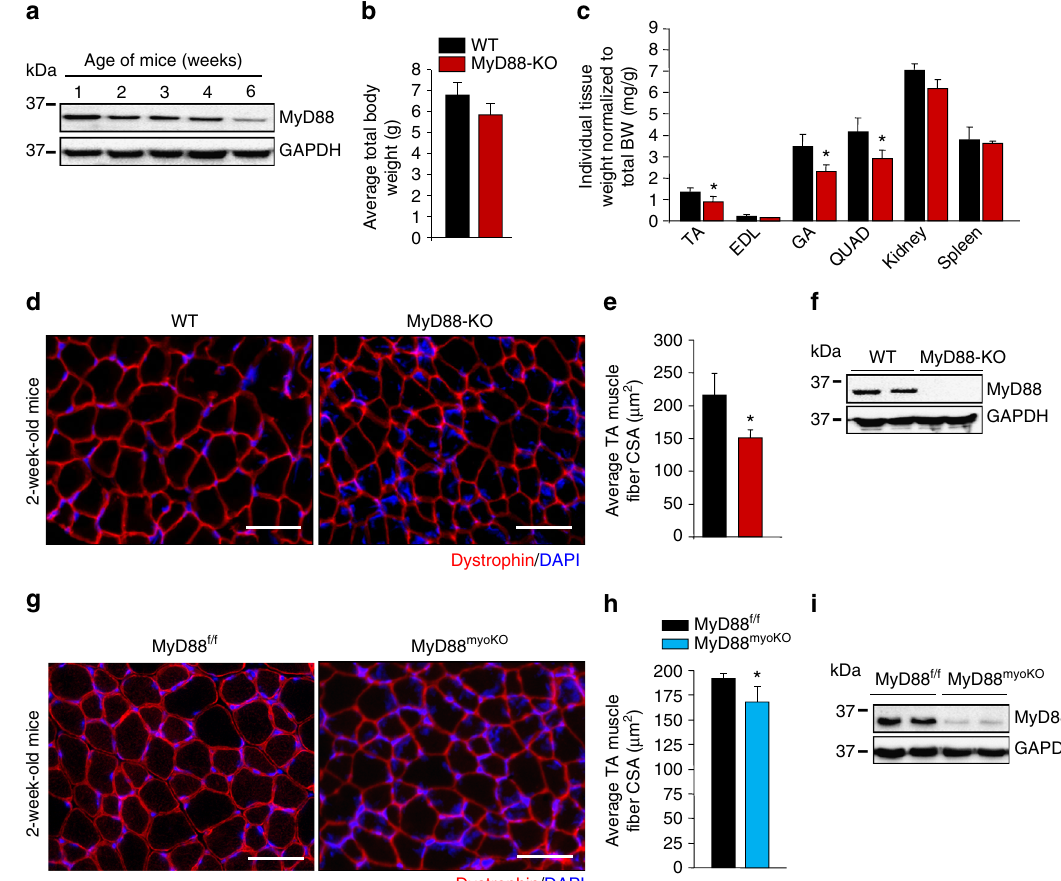
Fig. 1 MyD88 regulates postnatal growth of skeletal muscle. a Gastrocnemius (GA) muscle was collected from WT mice at indicated ages and protein extracts made were immunoblotted for MyD88 and an unrelated protein GAPDH. b Total body weight of 2-week-old WT and MyD88-KO mice. c Tibialis anterior (TA), extensor digitorum longus (EDL), gastrocnemius (GA), and quadriceps (QUAD) muscles, kidney, and spleen were isolated from 2-week-old WT and MyD88-KO mice and their individual wet weight normalized to body weight is presented here. N = 4 mice in each group. * p < 0.05 from WT mice by unpaired t -test. d TA muscle from 2-week-old WT and MyD88-KO animals was processed for histological and morphometric analysis. Representative photomicrographs of dystrophin-stained TA muscle sections from WT and MyD88-KO mice. Scale bar: 50 µ m. e Quanti fi cation of average myo fi ber cross- sectional area (CSA) in TA muscle of 2-week-old WT and MyD88-KO mice. N = 4 mice in each group. * p < 0.05 from WT mice by unpaired t -test. f Immunoblot presented here demonstrates absence of MyD88 protein in skeletal muscle of MyD88-KO mice. g Representative photomicrographs of dystrophin-stained TA muscle sections from 2-week-old MyD88 f/f and MyD88 myoKO mice. Scale bar: 50 µ m. h Quanti fi cation of average myo fi ber CSA in TA muscle of 2-week-old MyD88 f/f and MyD88 myoKO mice. N = 4 in each in each group. Error bars represent s.d. * p < 0.05 from MyD88 f/f mice by unpaired t -test. i Levels of MyD88 and unrelated protein GAPDH in skeletal muscle of MyD88 f/f and MyD88 myoKO mice measured by performing